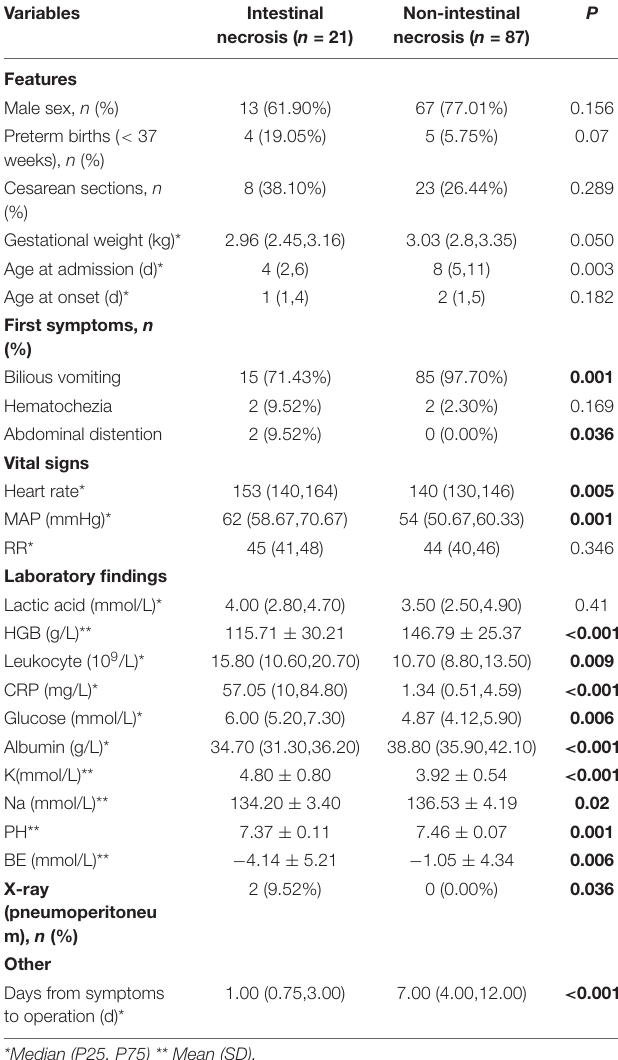
TABLE 1 | Analyses of clinical and laboratory parameters in midgut